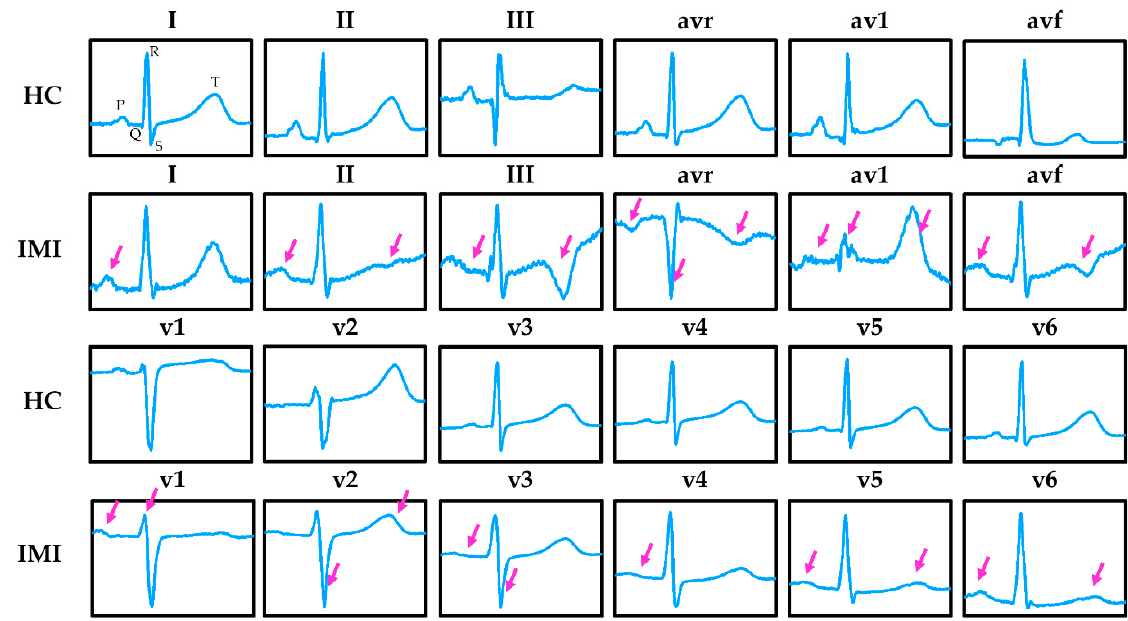
Figure 4. Samples of healthy control (HC) and inferior myocardial infarction (IMI) 12-lead ECG. IMI can be detected by the abnormalities waveform features of the ECG, as indicated by the arrows that include the ST displacement, T wave inversion, silent Q wave, and so on.